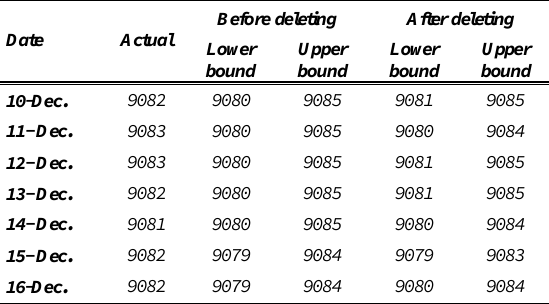
Table 1. Obtained results in stage III for test data before and after deleting outlier data *